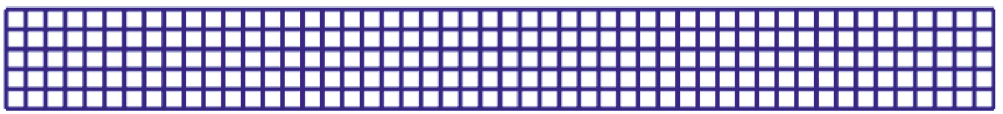
Figure 14: Domain discretization of beam using four-node element with regular elements.